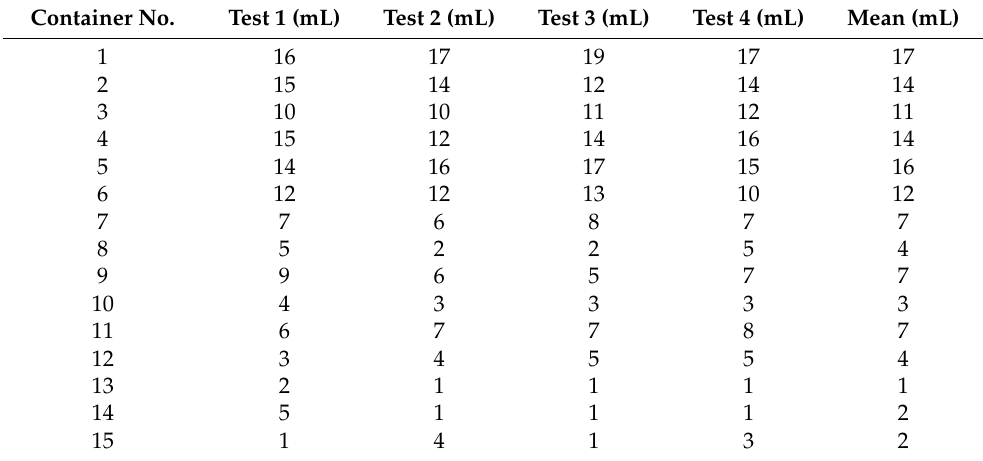
Table 2. Calibration results for the simulator hanging from the aluminum structure. Container No.